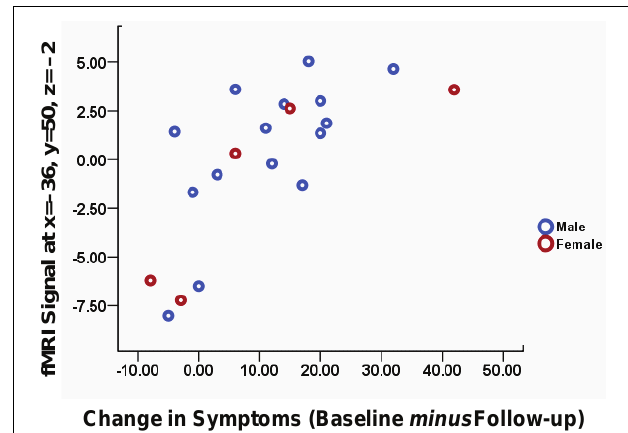
Change in Symptoms (Baseline minus Follow-up) FIGURE 3 | Scatter plot of left inferior frontal gyrus activity during the self-undistorted condition against the change in symptoms in CBTp + TAU patients classifi ed by